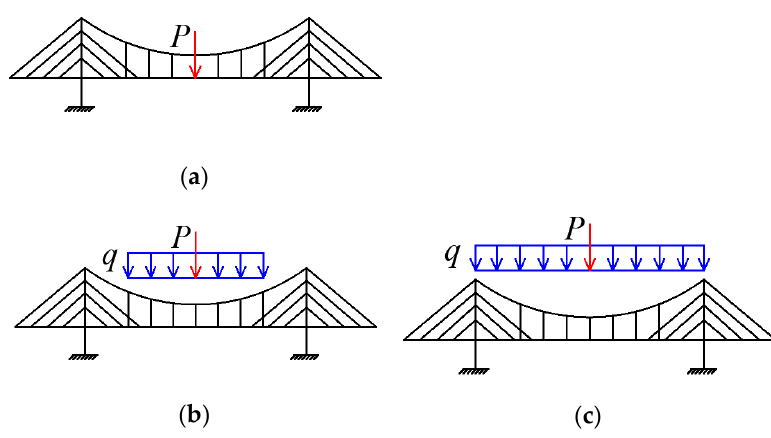
Figure 7. Load combinations. ( a ) Load combination 1 ( P = 500 N). ( b ) Load combination 2 ( P = 250 N, q = 125 N/m). ( c ) Load combination 3 ( P = 250 N, q = 125 N/m).